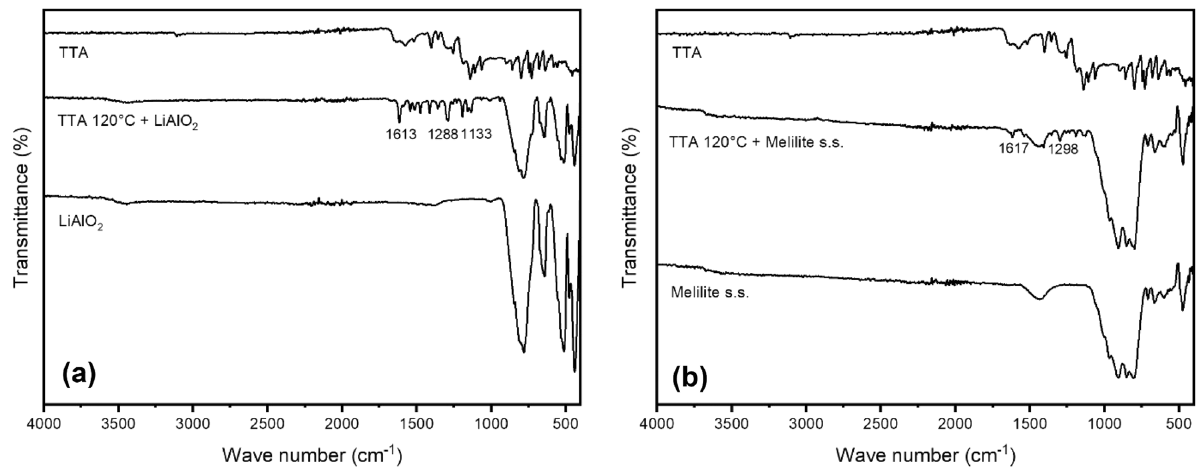
Figure 7. FT-IR measurement of TTA functionalized LiAlO 2 ( a ) and Melilite s.s. ( b